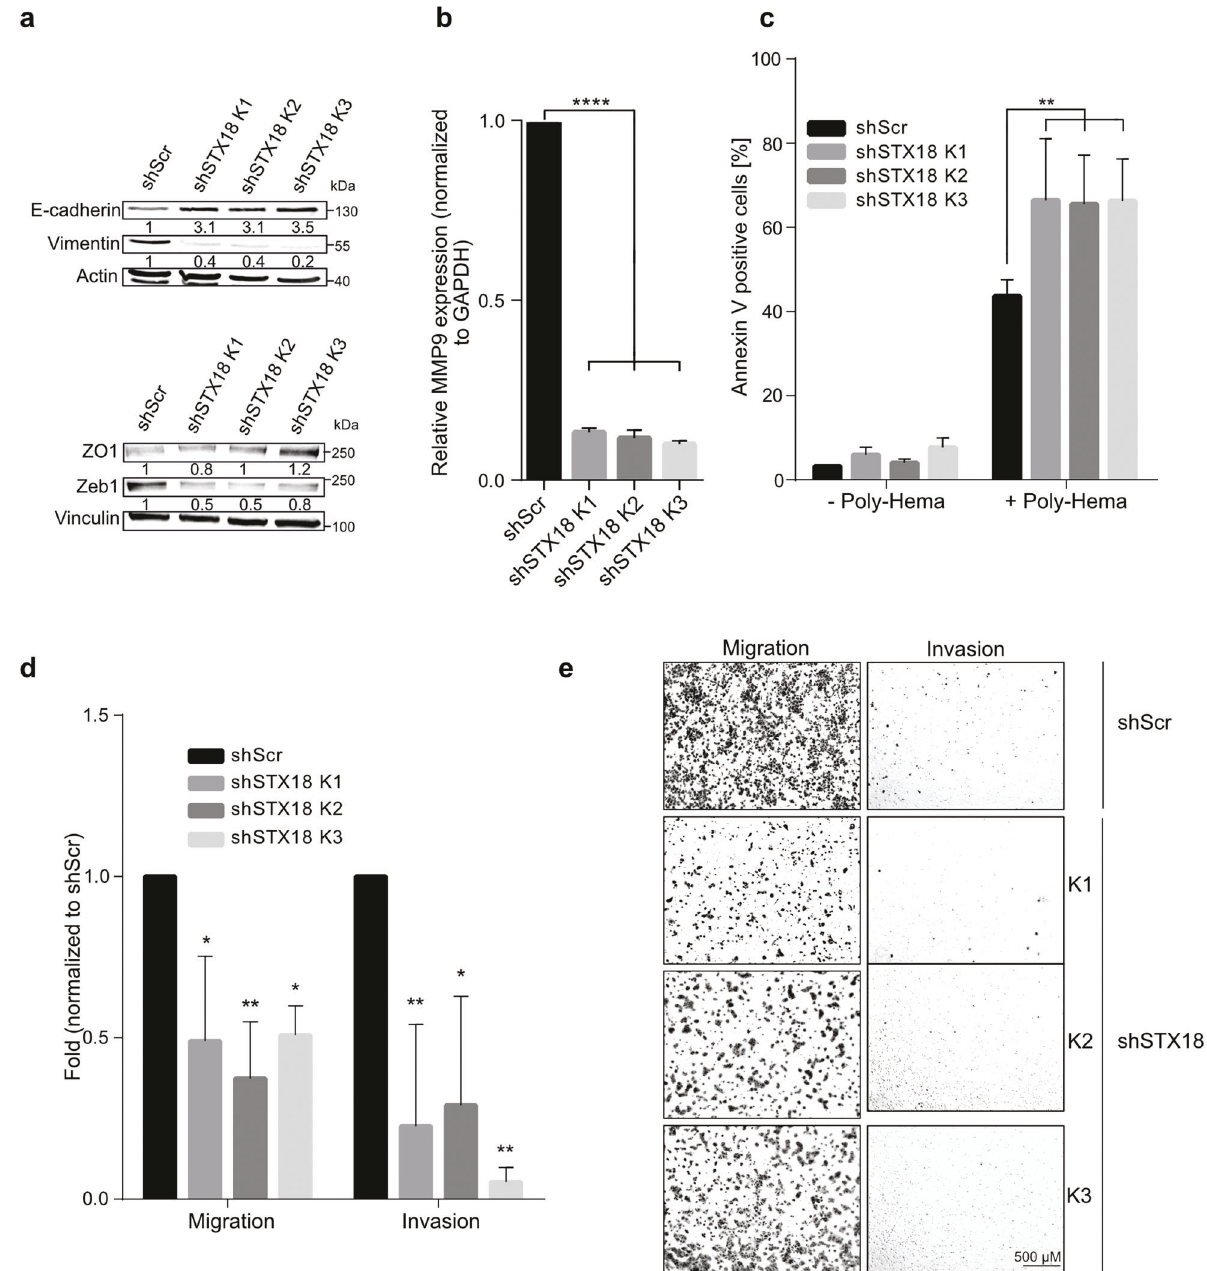
Fig. 5 Syntaxin 18 knockdown leads to an epithelial phenotype and decreased migration and invasion capacities in A549 cells. a Immunoblotting analysis of E-cadherin, vimentin, ZO-1 and Zeb1 expression. Vinculin and actin were used as controls. After normalization